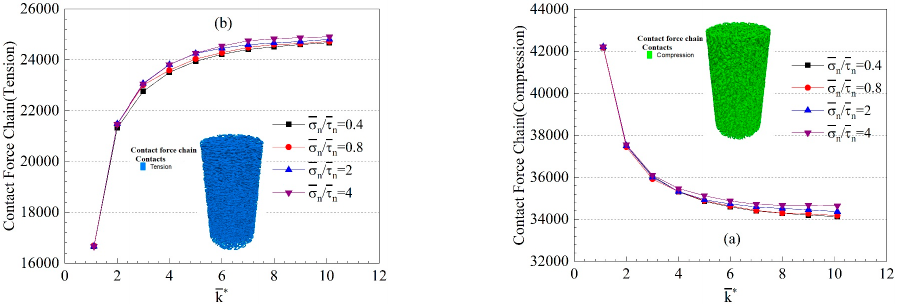
∗ ) for di ff erent σ n / τ n . * k ) for different / n n σ τ .